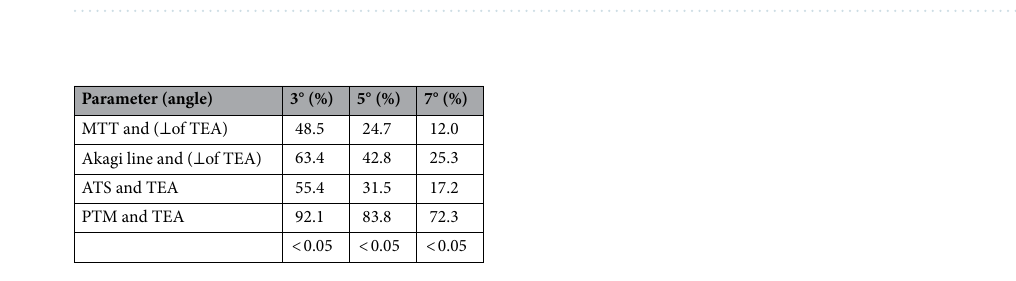
Table 1. Comparison of anthropometric measurements between Korean males and females. n.s. non- significant.